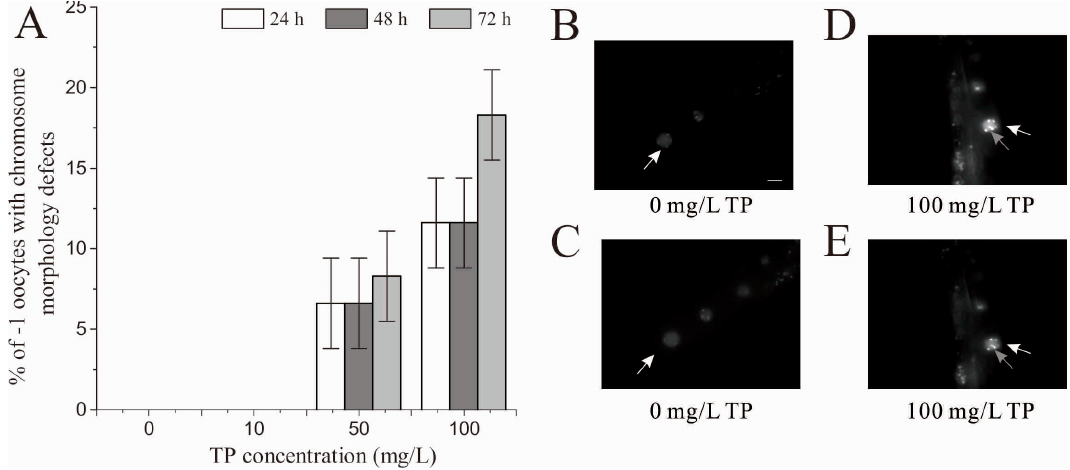
Figure 9. Effects of exposure to TP for 4 h on the chromosome of − 1 oocytes in diakinesis: ( A ) percent of − 1 oocytes with chromosome morphology defects; ( B , C ) the chromosome of the same − 1 oocyte in diakinesis of the control group on different focal planes, with six intact DAPI-stained bodies distributed dispersedly in the nucleus; and ( D , E ) the chromosome of the same − 1 oocyte in diakinesis of 100 mg/L TP group on different focal planes. A chromatin aggregate was observed in the nucleus. White arrows point to the − 1 oocytes. Grey arrows point to the chromatin aggregates. Scale bar is 10 µm. TP, Triptolide. Bars represent means ± SEM.